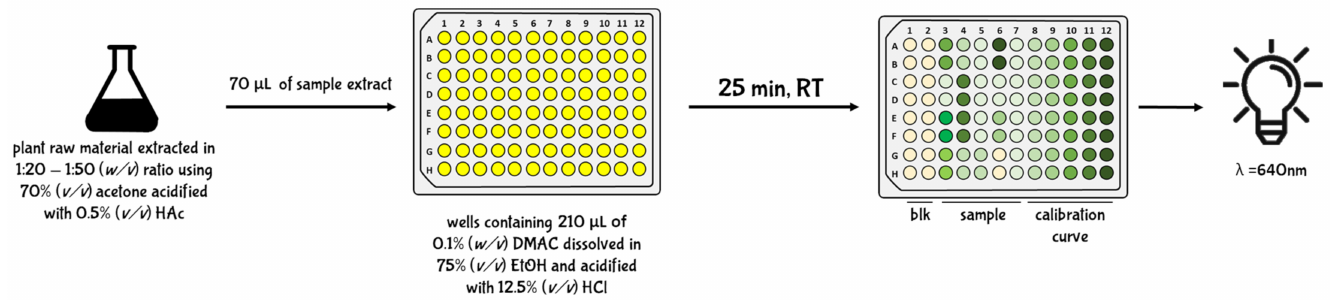
Figure 11. Schematic representation of BL-DMAC assay for the detection and quantification of